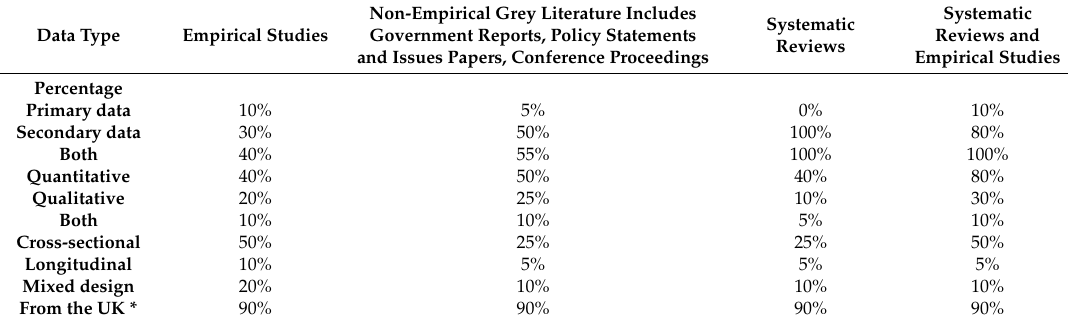
Table 2. Details of the evidence base criteria: percentages reflected were rounded